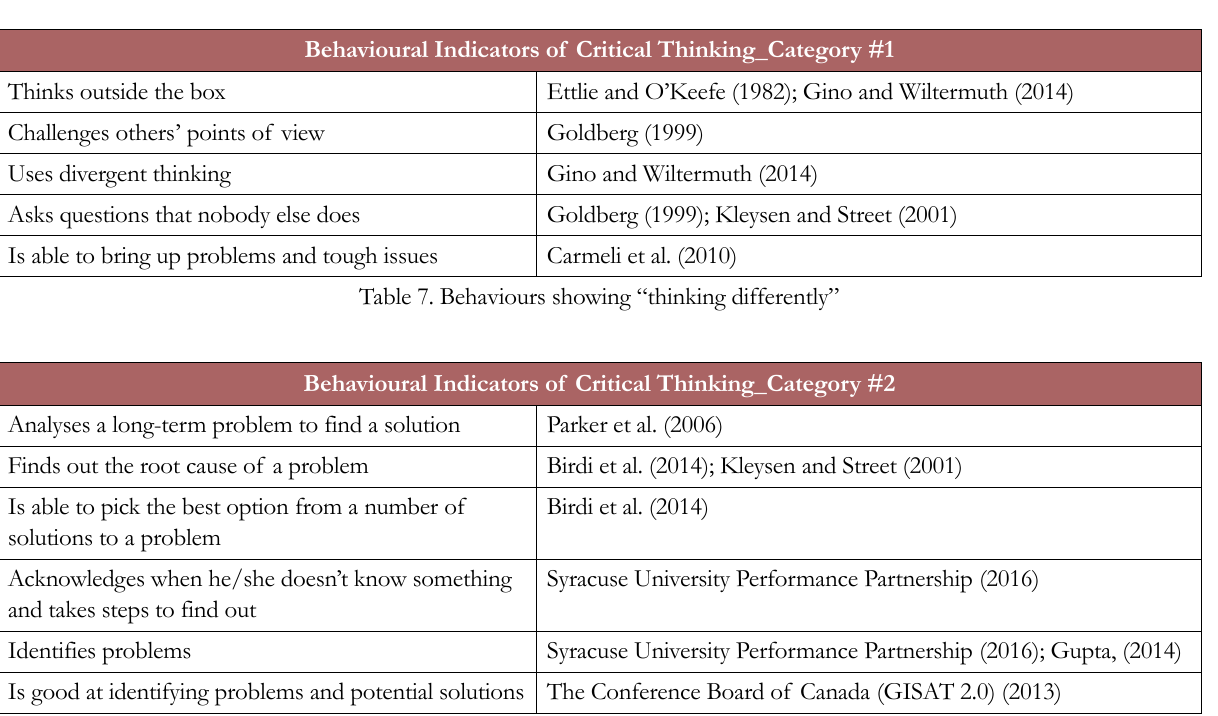
Table 8. Behaviours showing “analysing and identifying”